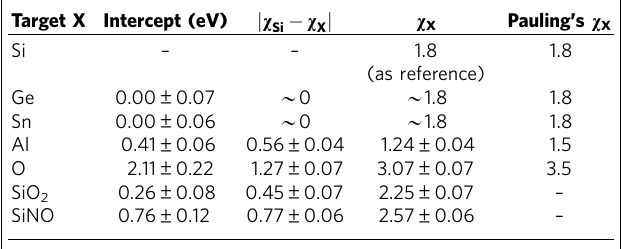
Table 1 | Summary of experimental and calculated slopes ffiffiffiffiffiffiffiffiffiffiffiffiffiffiffiffiffiffiffiffiffiffiffiffiffiffi E p(cid:2) (cid:3) . X (cid:3) X = E Si (cid:3) Si